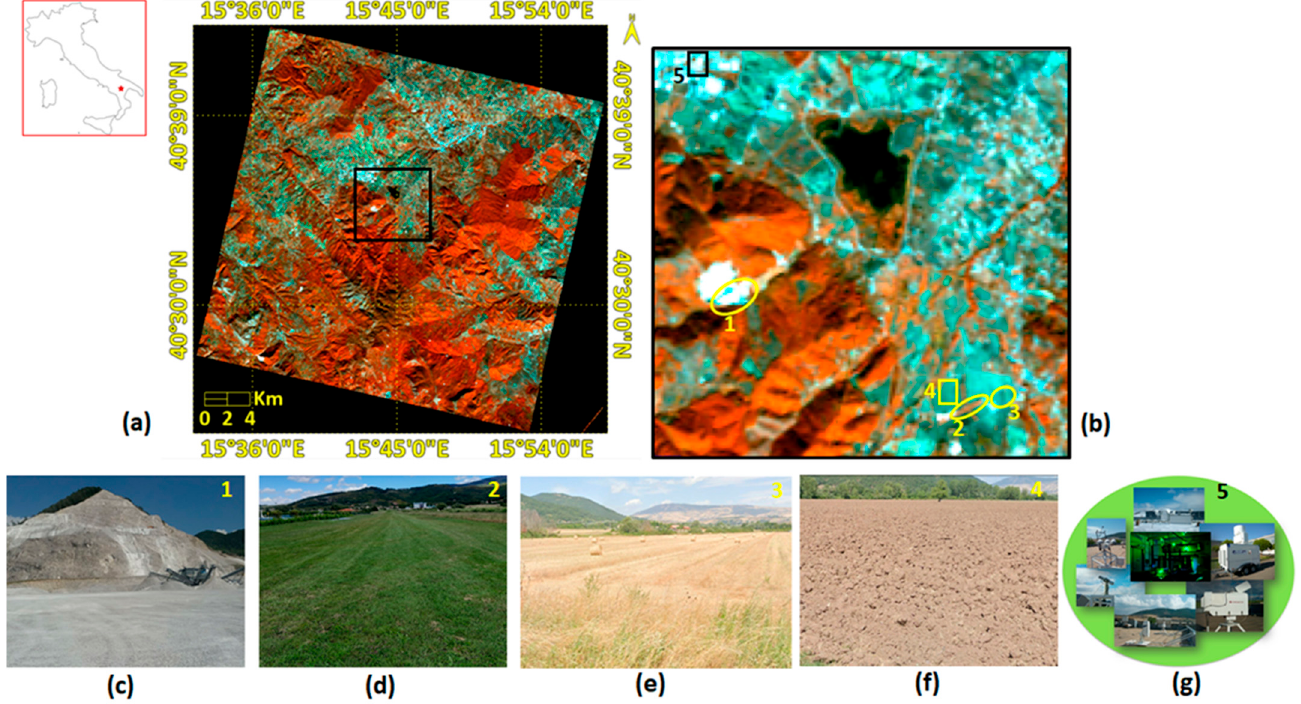
Figure 1. ( a ) PRISMA image of 14 October 2019 with a superimposed black box indicating the zoomed-in image ( b ) of the study area of Pignola, Italy (R: 729 nm; G: 562 nm; B: 492 nm); ( b ) zoomed-in PRISMA image of the Pignola test area with superimposed yellow shapes (1–4) indicating the ground measurements targets (photos ( c – f )) applied for the PRISMA radiance and reflectance performance assessment, while the black box (5) shows the location of the CIAO ( g ).